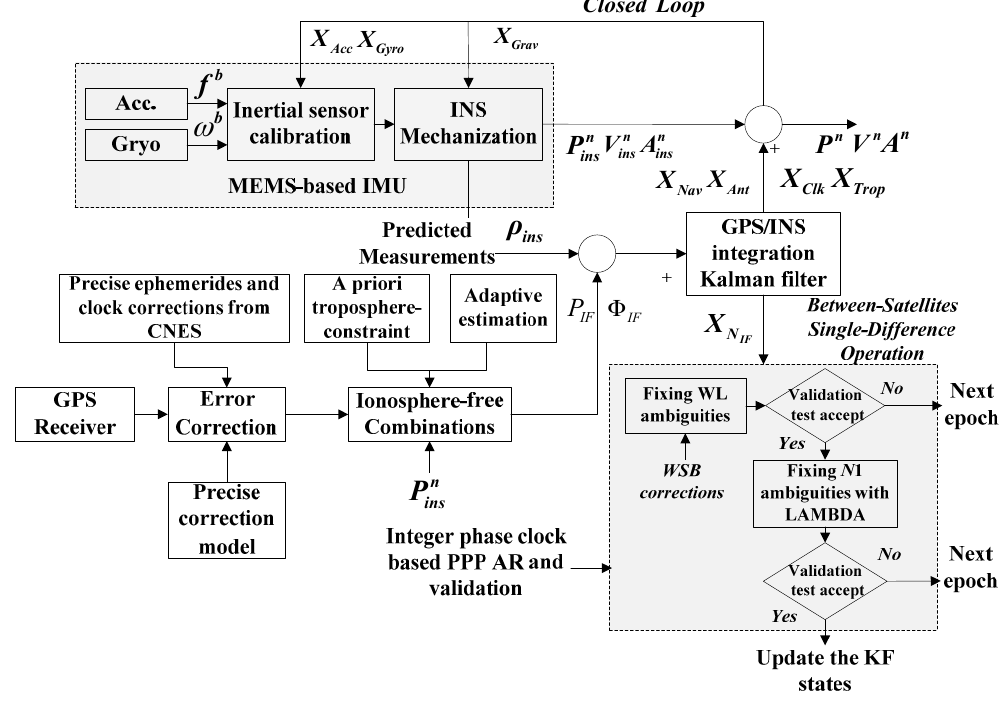
Figure 1. The GPS PPP/INS tightly coupled integration with fixed-ambiguities through a troposphere- The GPS PPP/INS tightly coupled integration with fixed-ambiguities through a constrained adaptive Kalman filter. troposphere-constrained adaptive Kalman